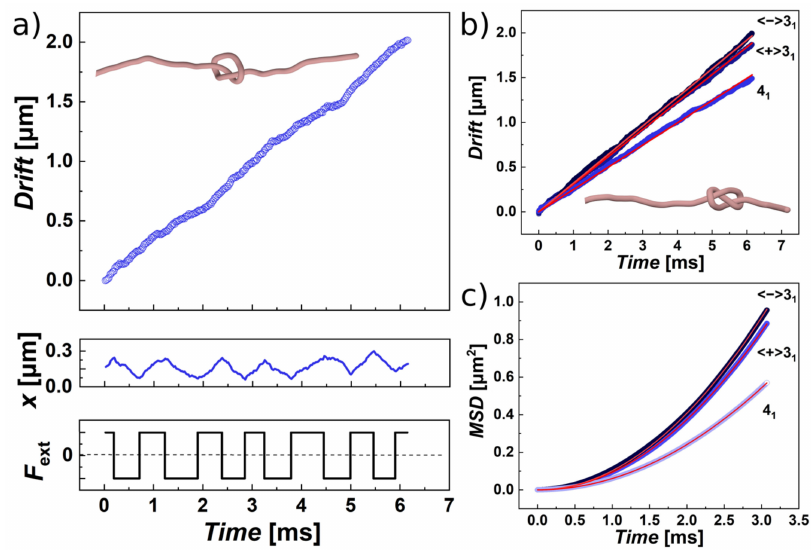
Figure 1. Drift analysis of knots along polymer chain from molecular trajectories. ( a ) The figure shows the distance ∆ x travelled by the drifting knot as a function of time. A snapshot from the simulation shows the shape and localization of a trefoil knot, <+>3 1 . The graph in the middle shows the instantaneous position of the knot along the polymer, x . The sawtooth pattern emerges from the changes of the direction of external pulling force. The bottom graph shows the periods of pulling with positive or negative force F ext = 0.05 ε 0 / σ = 0.07 pN oriented along the x -axis. ( b ) The graph shows drifted distance for selected knots (<+>3 1 , < − >3 1 and 4 1 ) with linear fits (red lines) with the slope corresponding to the drift speed. A snapshot from the simulation shows the shape and localization of the achiral 4 1 twist knot. ( c ) The panel shows ballistic behavior of mean square displacement ( MSD ) typical for movement of particles in the presence of external force fitted by quadratic equation (0.05 × Dt / σ ) 2 + 2 Dt (shown as red lines) in order to obtain